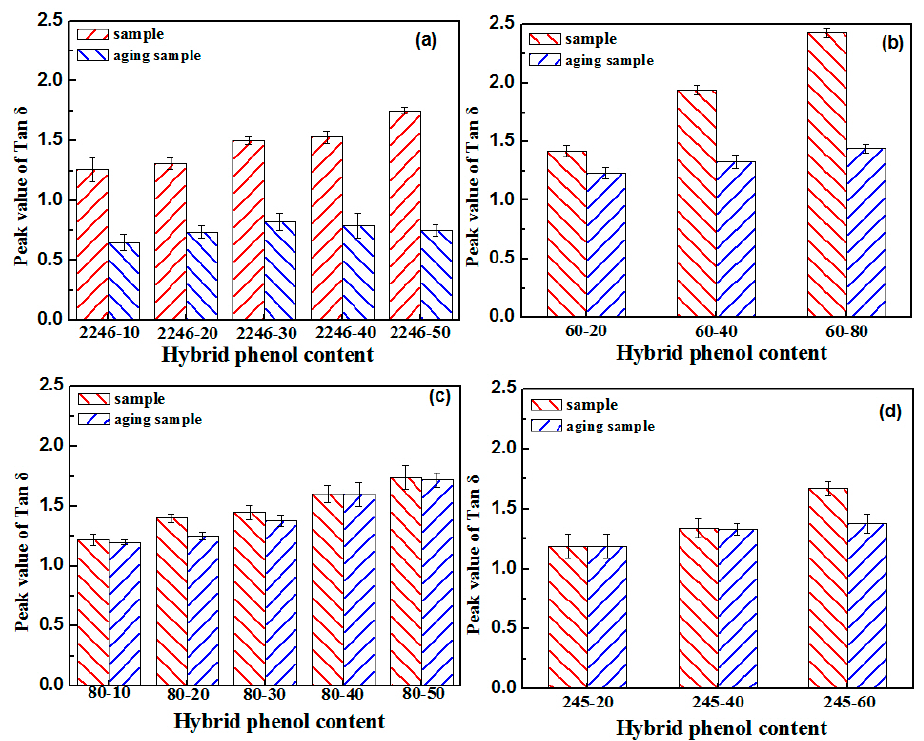
Figure 5. Comparison of the peak of tan δ of XNBR/hybrid phenol blends after thermal aging ( a ) Peak value of tan δ of XNBR/AO-2246; ( b ) Peak value of tan δ of XNBR/AO-60; ( c ) Peak value of tan δ of XNBR/AO-80; ( d ) Peak value of tan δ of XNBR/ XH-245.